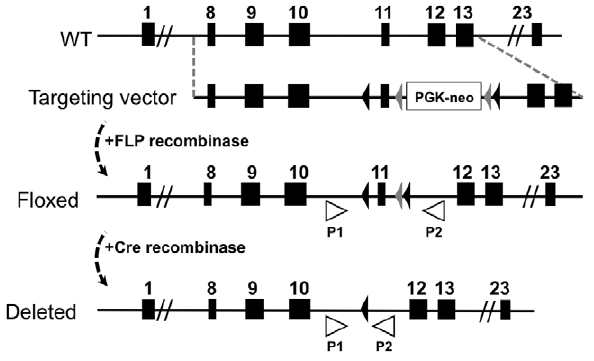
Figure 1. Schematic representation of the Atp7a gene-target- ing strategy. Exons 8–13 of the wild type and recombinant Atp7a locus are shown. The targeting construct included LoxP sites (black triangles) that flanked exon 11 and a PGKneo gene cassette flanked by FRT sites (grey triangles). The PGKneo gene cassette was removed by crossbreeding with the ACT-FLPe deleter strain expressing FLP1 recombinase to generate mice with the desired floxed allele ( Atp7a fl ). The exon 11-deleted Atp7a allele (Deleted) is depicted following excision by Cre recombinase, which was detected using PCR primers P1 and